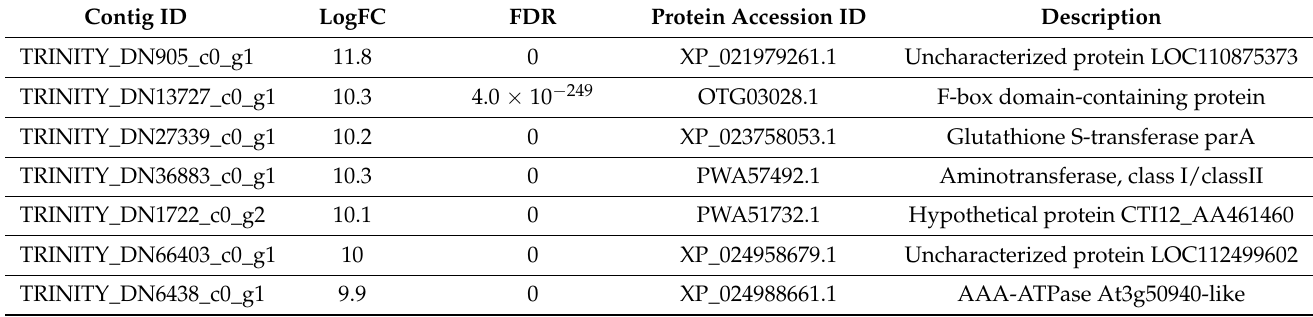
Figure 1. Summary of DEG analysis in TNRG vs. TNRC, and TNSG vs. TNSC. ( a ) Principal coordinates analysis (PCA) of gene-level and isoform-level transcript expression plot of TNS and TNR treated with glyphosate or water. ( b ) Correlation plot of FC variation in TNRG vs. TNRC against TNSG vs. TNSC. Correlation coefficient was determined by the Pearson method. ( c ) Bar graph of the percentage of gene counts of DEGs involved in the biological process category of GO terms. Table 2. The gene list of the top 20 upregulated genes in TNRG vs. TNRC. De novo transcriptome analysis was performed by Trinity with 11 libraries (6 glyphosate-treated and 5 non-treated leaves). DEGs were analyzed by edgeR software. Statistically, a total of 3640 transcripts were upregulated over 4 FC in TNRG than TNRC (FDR < 0.05). Among them, the top 20 genes are listed in this